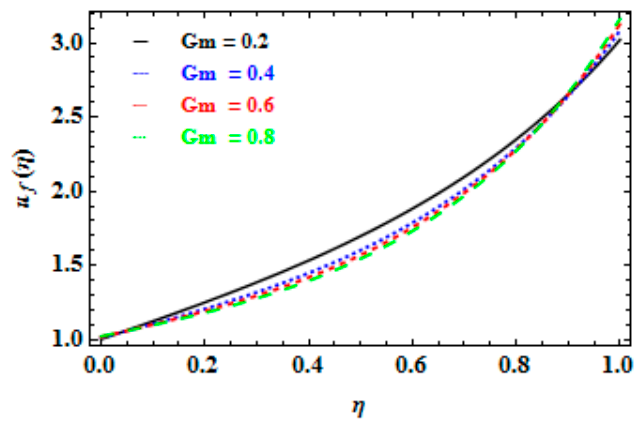
Figure 7. Influence of G m on 𝑓 (cid:4593) ( 𝜂 ) .